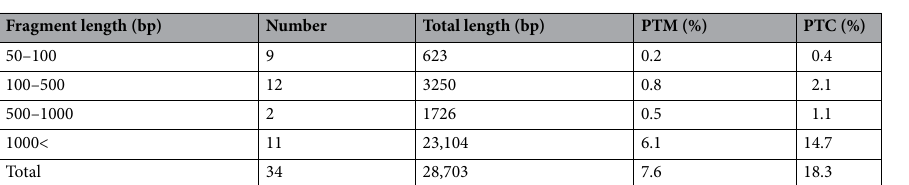
Table 3. Summary of the transfer of sequences from chloroplast to mitochondrial genomes in C. lanatus. PTM Percentage of transferred sequences in mitochondrial genome, PTC percentage of transferred sequences in chloroplast